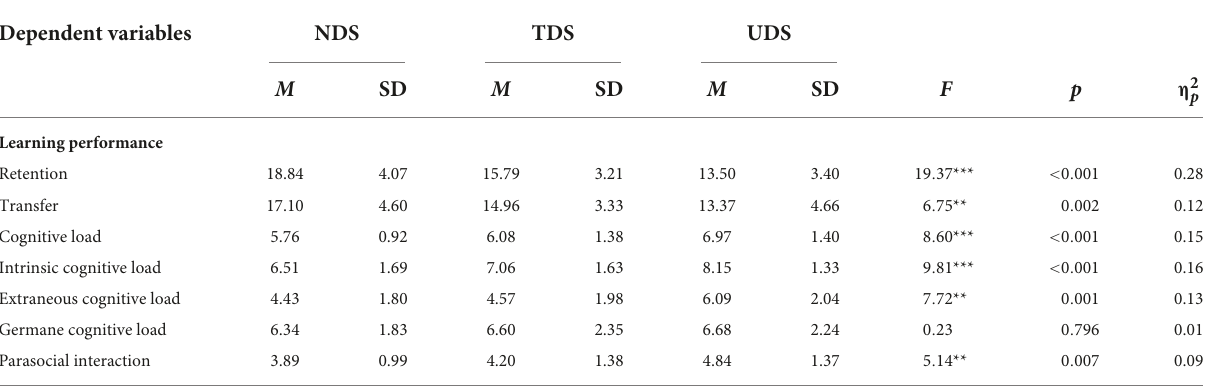
TABLE 2 Means and standard deviations of all variables by